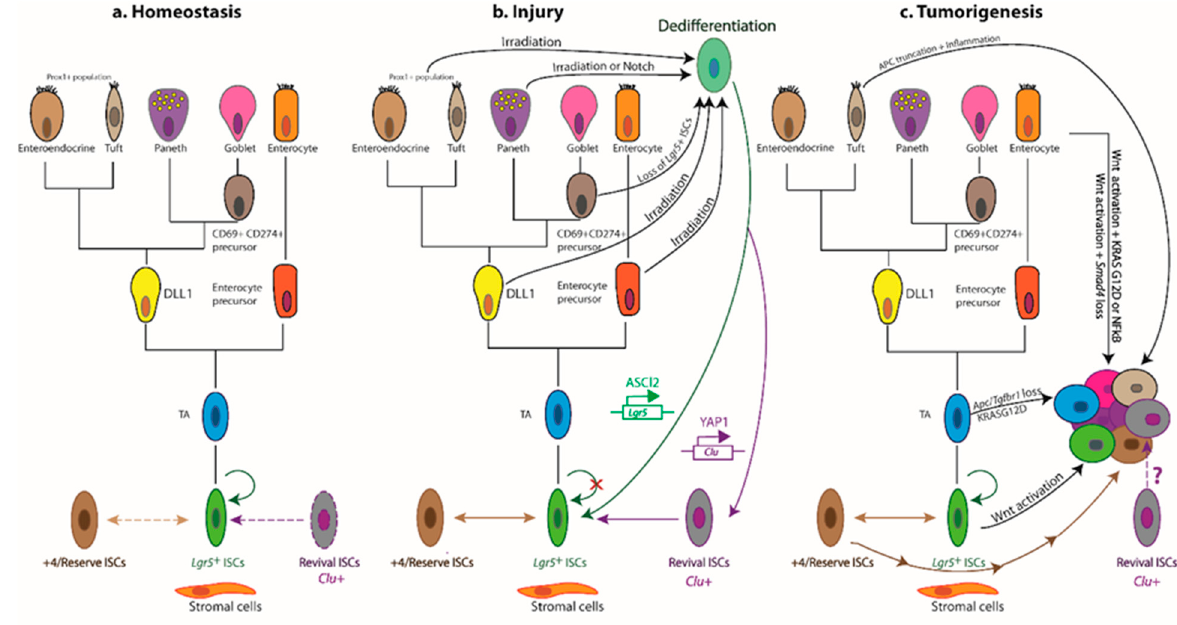
Figure 2. Cellular hierarchies and phenotypic plasticity in the intestinal epithelium during homeostasis, post-injury regeneration, and tumorigenesis. The dendrograms summarize key lineage relationships between Lgr5 ⁺ ISCs, transit-amplifying (TA) cells, lineage-committed precursors, terminally differentiated intestinal cell types, +4/reserve ISCs, and revival stem cells in different settings. ( a ) The homeostatic remodelling of the intestinal epithelium is orchestrated by niche signals that fine-tune the balance between Lgr5 ⁺ ISC self-renewal and differentiation. Revival stem cells are rare under homeostatic conditions (dashed boundary), and +4/reserve ISCs contribute only weakly to daily turnover during homeostasis (double-headed dashed arrow). ( b ) Following ablation of Lgr5 ⁺ ISCs post injury, +4/reserve ISCs can mobilize to replenish lost Lgr5 ⁺ ISCs and repopulate damaged crypts. Differentiated Lgr5 ⁺ progeny upregulate C lu in a YAP1-dependent manner, transiently serving as revival stem cells that can generate Lgr5 ⁺ ISCs de novo. Lineage-committed precursors and/or fully differentiated cells can dedifferentiate, revert to an Lgr5 ⁺ state, and regain stem-like traits. The transcription factor ASCL2 is critical for the ability of recent Lgr5 ⁺ ISC progeny to undergo dedifferentiation to an Lgr5 ⁺ state. Of note, Clu ⁺ cells are distinct from the Lgr5 ⁺ and Ascl2 ⁺ populations. ( c ) Aberrant activation of Wnt signalling drives unbridled proliferation of Lgr5 ⁺ ISCs leading to intestinal hyperplasia. TA and differentiated cells, with hyperactive Wnt signalling and mutant KRAS G12D , may progress to malignancy in the context of TGF β -receptor loss or inflammation (i.e., NF κ B activation). Multiple +4/reserve ISCs can also initiate tumorigenesis, and tuft cells are readily transformed by inflammation following Apc loss. Whether revival stem cells can serve as tumour-initiating cells remains unclear. Solid arrows indicate the ability to dedifferentiate and revert to a stem-like state, or the susceptibility to transformation and hyperplastic progression. Reflexive arrows indicate the ability to self-renew. Double-headed solid arrows denote dynamic interconversion between indicated cell types. Note that, to date, goblet cell progenitors have not been lineage-traced.